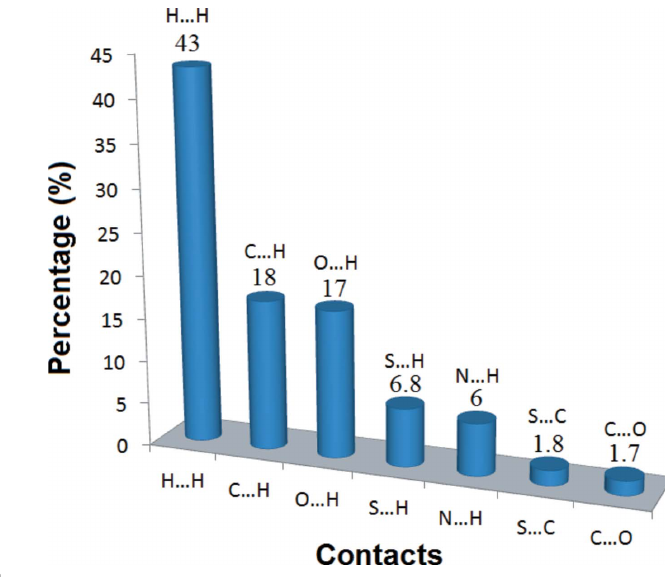
Figure 4 Intermolecular interactions and their percentages in C 18 H 18 N 2 O 3